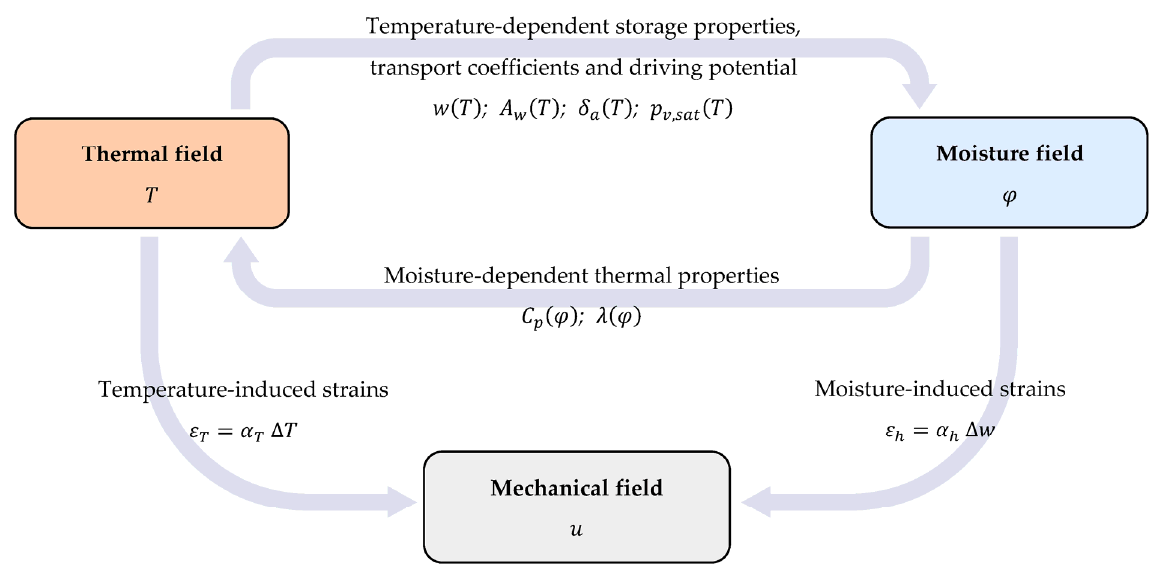
Figure 9. Schematic diagram of the proposed one-way coupled hygro-thermo-mechanical model.